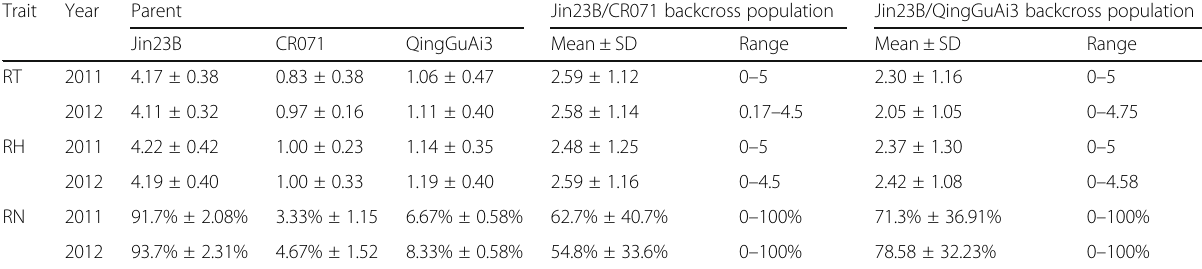
Table 1 Statistical description of the parents and the backcross population in 2 years